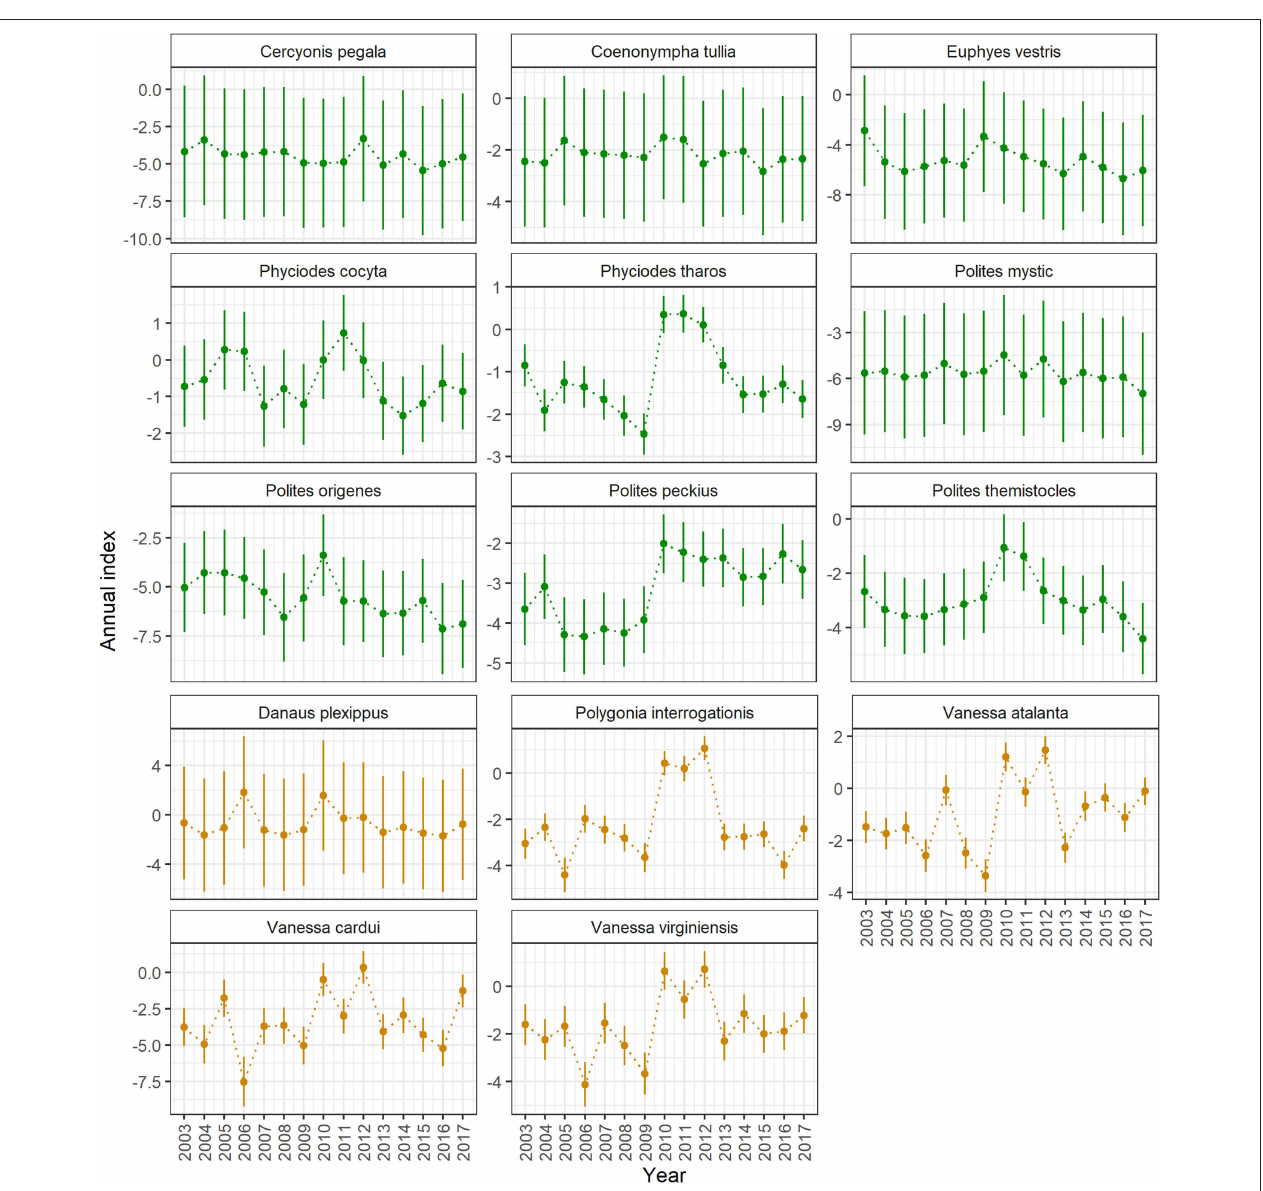
FIGURE 1 | Annual indices ( ± std. dev.) of breeding population size for resident (top 3 rows, green) and migrant (bottom 2 rows, orange) butterfly species detected by the Ontario Butterfly Atlas (2003–2017). Indices were estimated using hierarchical linear regression that assumed a negative binomial data distribution, with count as the dependent variable, and with residuals of list length by latitude (a measure of effort), and year (factor) as explanatory variables. Temporal autocorrelation among years and among days within years were accounted for through the specification of random year and day effects.